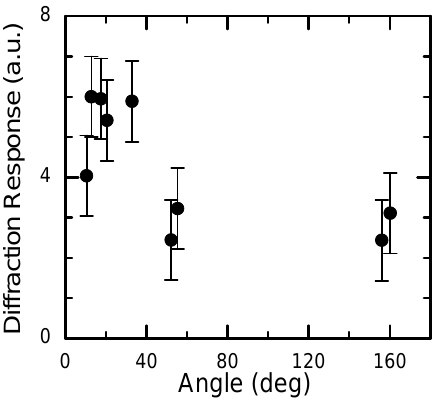
Figure 20. Dependency of diffraction efficiency of hologram in CdF crystal on the convergence angle of recording